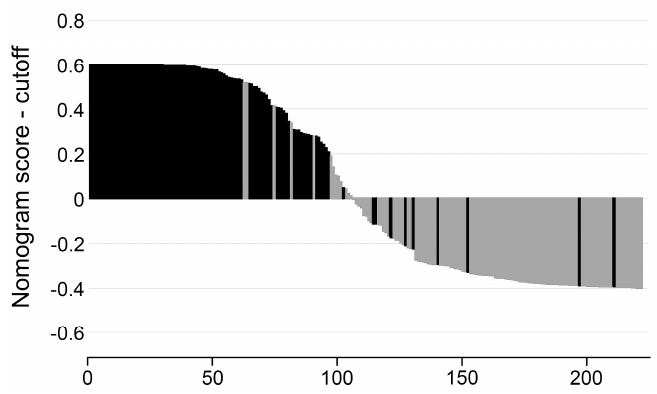
Figure 5. Bar diagrams of BI-RADS 4 lesions according to the optimal cutoff value of nomogram score. Vertical axis refers to the nomogram score minus the optimal cut-off value (i.e., Nomo-score − 0.40). Up and down bars refer to the biopsy group (Nomo-score > 0.4, n = 106) the follow-up group (Nomo-score ≤ 0.4; n = 117), respectively. Black and grey bars refer to actual malignant and benign lesions, respectively.